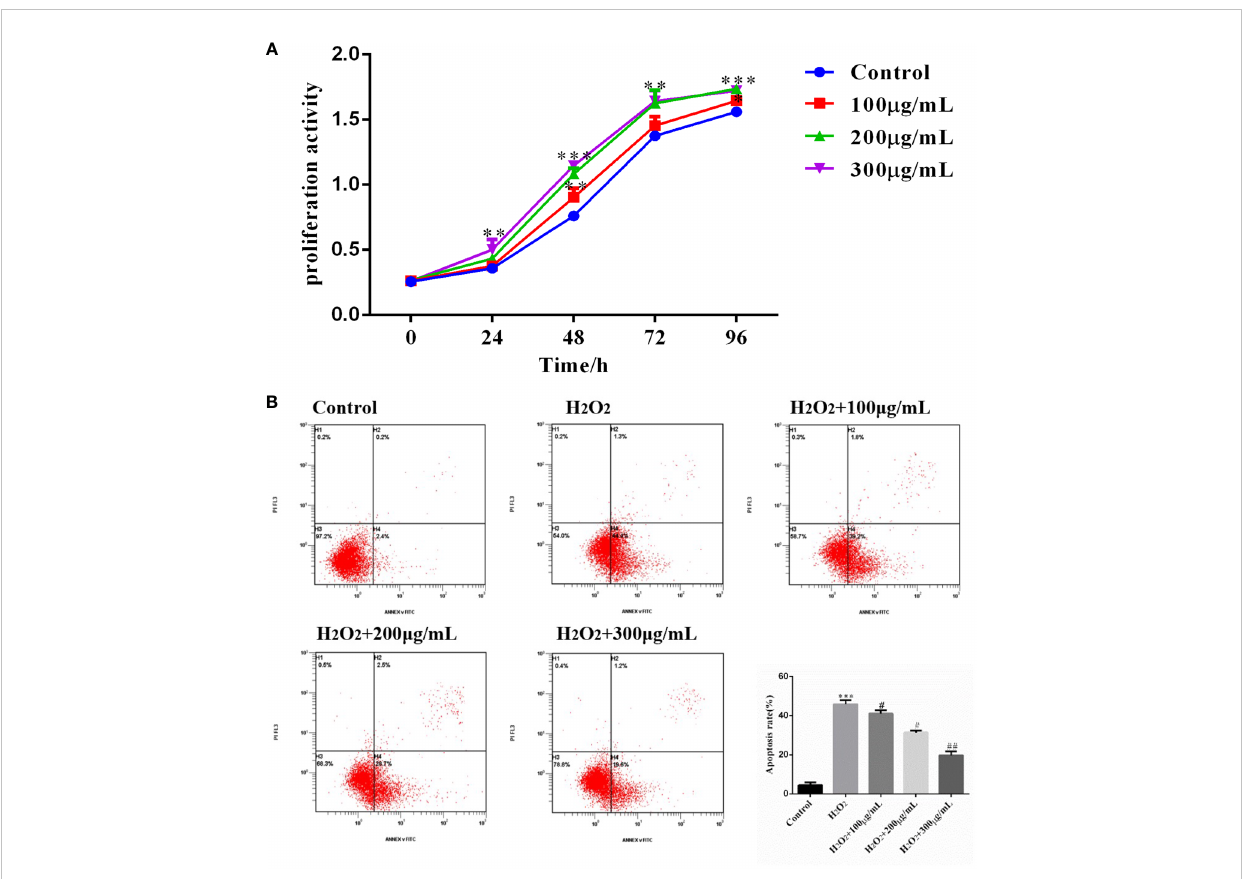
FIGURE 4 COS promoted KGN cell proliferation and inhibits apoptosis. The cell proliferation curve shows that the COS promotes the proliferation of KGN cells in a dose and time-dependent relationship (A) . COS reverse H 2 O 2 -induced apoptosis of KGN cells (B) . * P < 0.05, ** P < 0.01, *** P < 0.001 vs Control group; # P <0.05, ## P <0.01 vs H 2 O 2